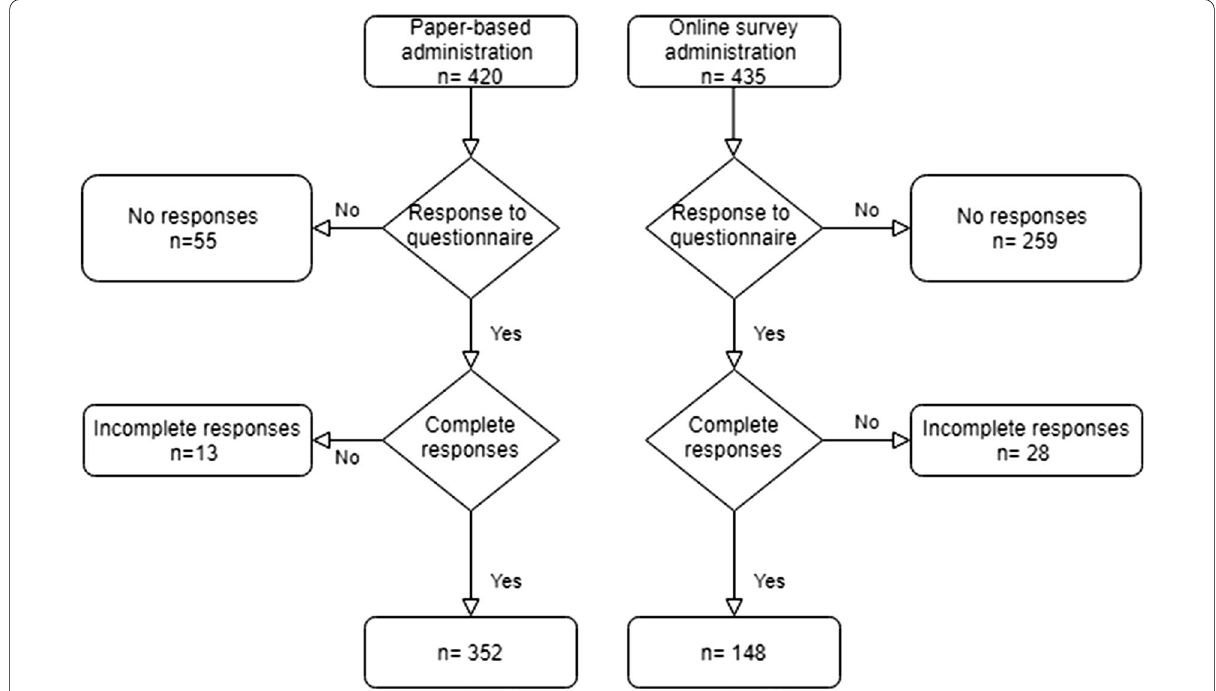
Fig. 1 Flowchart of the number of participants included in the